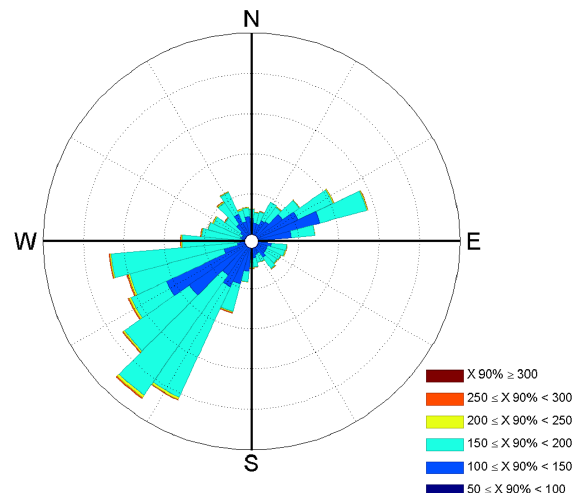
Figure 5. Sundarbans flux tower foot print of 90% of the flux contribution (represented by X 90%) over the study period ranged from 90 m to 300 m.